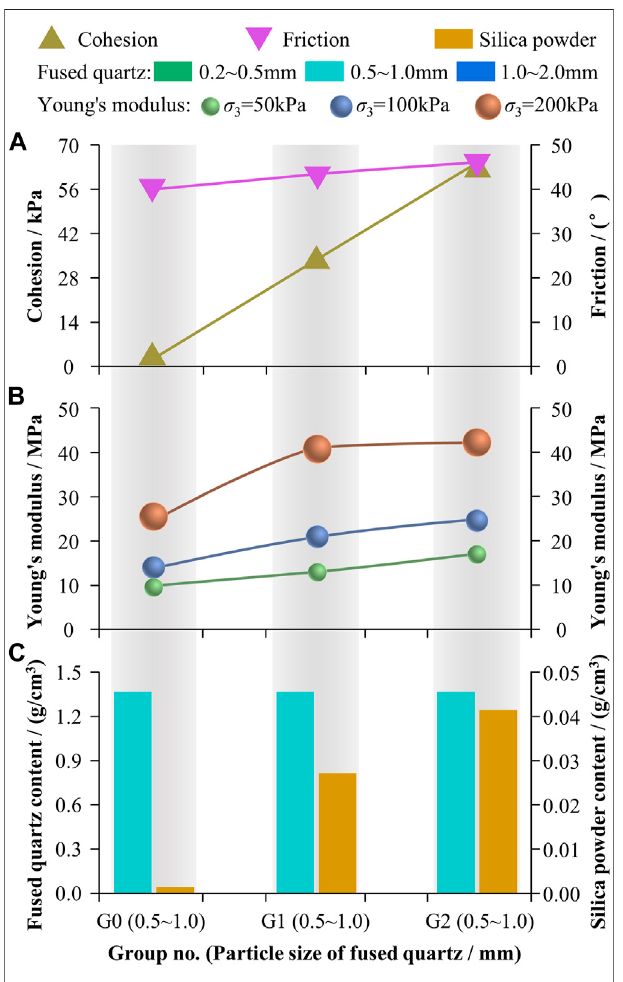
FIGURE 8 | Variations in geotechnical parameters of TCS with different mass ratios of silica